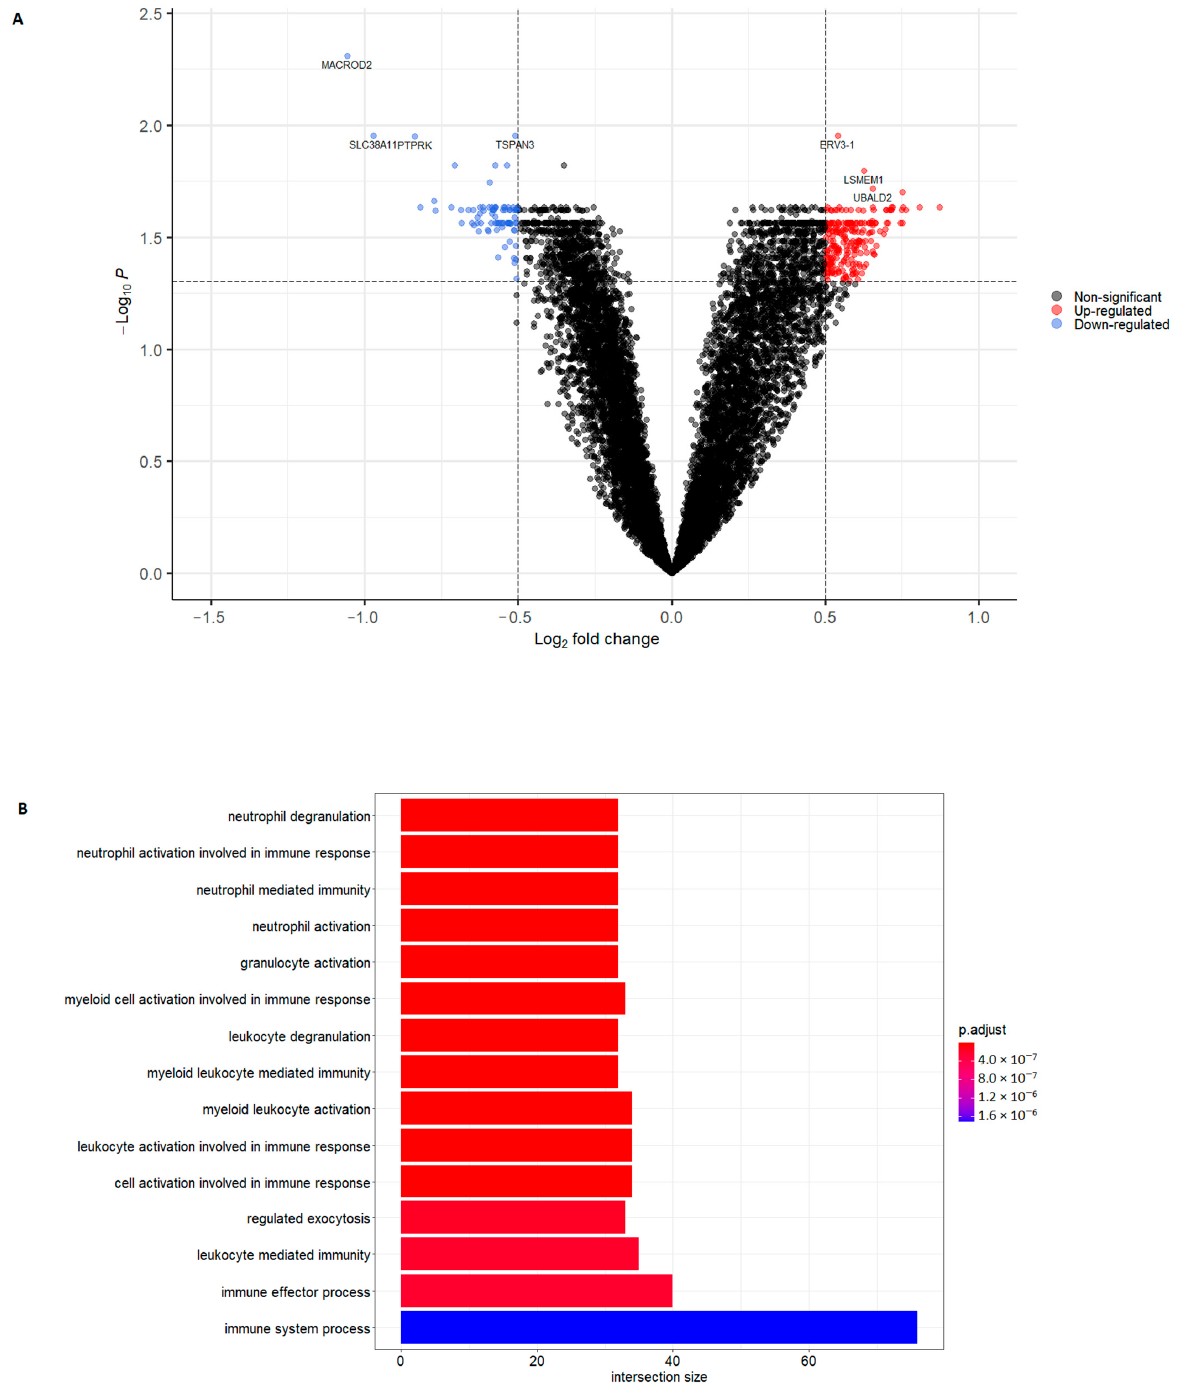
Figure 1. Differential expression analysis comparing patients with psoriasis with and without cardiovascular disease (CVD), and functional enrichment analysis of upregulated differentially expressed genes (DEGs). ( A ) Volcano plot showing the distribution of all protein-coding genes. DEGs were defined by a false discovery rate (FDR) of <0.05 and |log2 fold change| > 0.50. Dashed lines indicate FDR and log2 fold change thresholds. ( B ) Gene Ontology (GO) functional enrichment for biological processes for the upregulated DEGs. The 15 most significant biological processes are shown. The intersection size indicates how many of the upregulated genes included in the analysis were annotated to the specific GO biological process. Significance level, adjusted p -value =